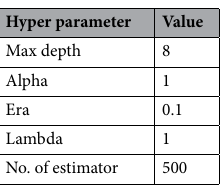
Table 1. Hyper parameters of the